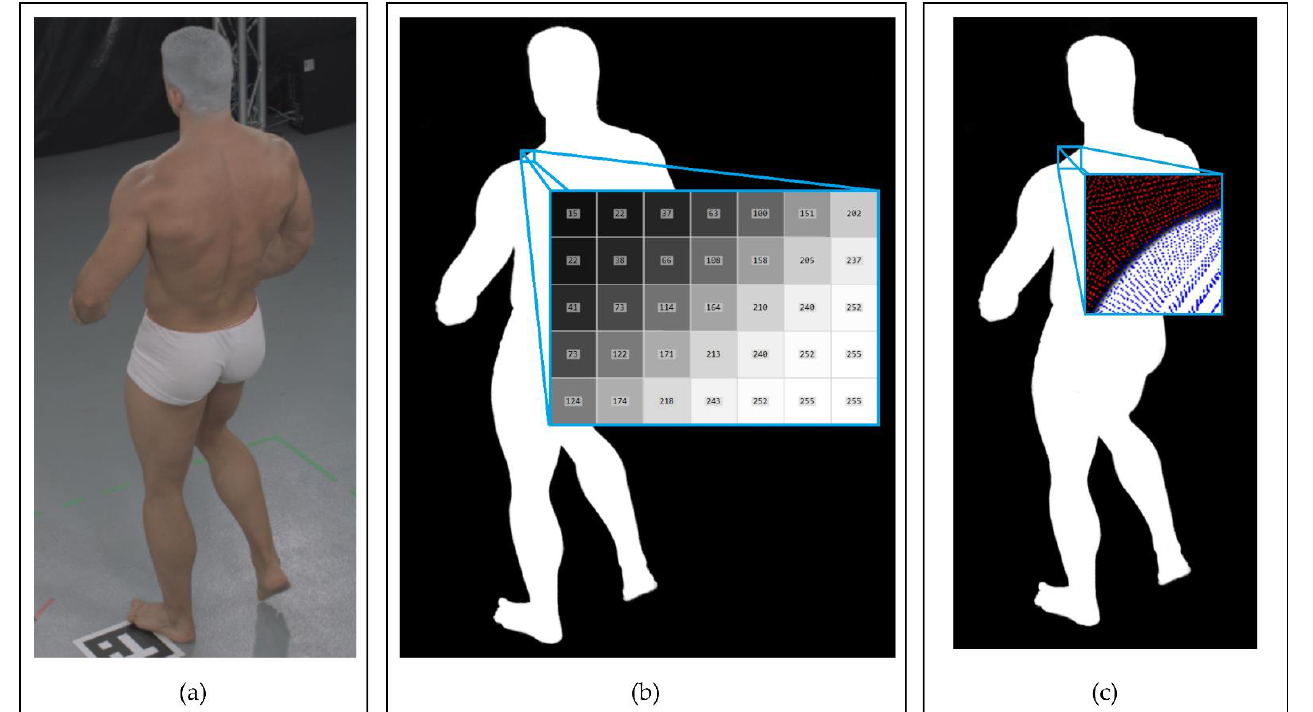
Figure 4. Example of Omnimatte [61] silhouette estimation performance with voxel projections onto the image (data sample #9): ( a ) input RGB image; ( b ) silhouette image with magnified silhouette quality values on its edge; ( c ) voxel center projections onto the silhouette. The projections in the image are marked with pixel-sized dots. The blue pixels represent the silhouette, and the red represent the background.